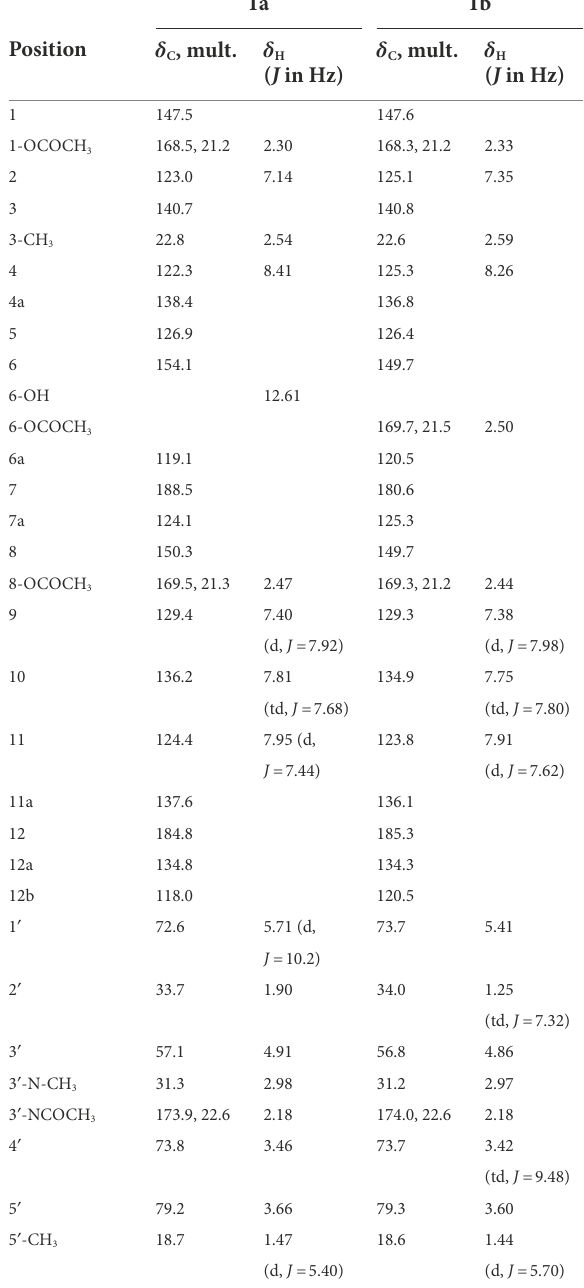
TABLE 1 1 H NMR and 13 C NMR data of compounds 1a and 1b in CDCl 3